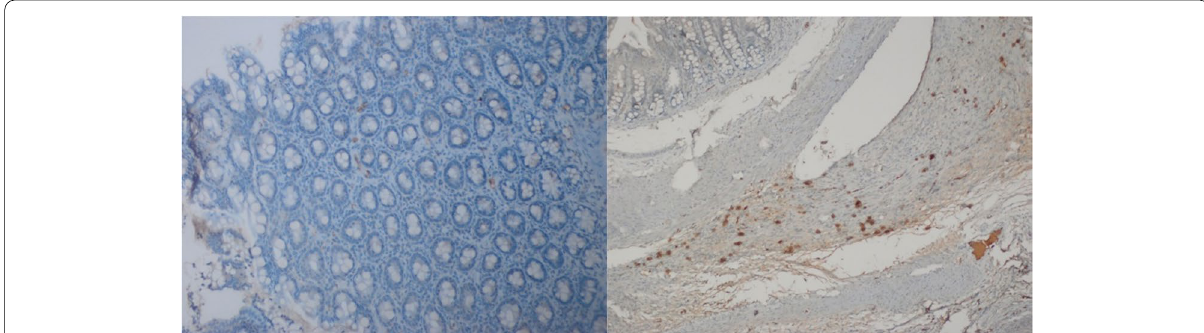
1 (left), and clusters containing 5–10 cells were +